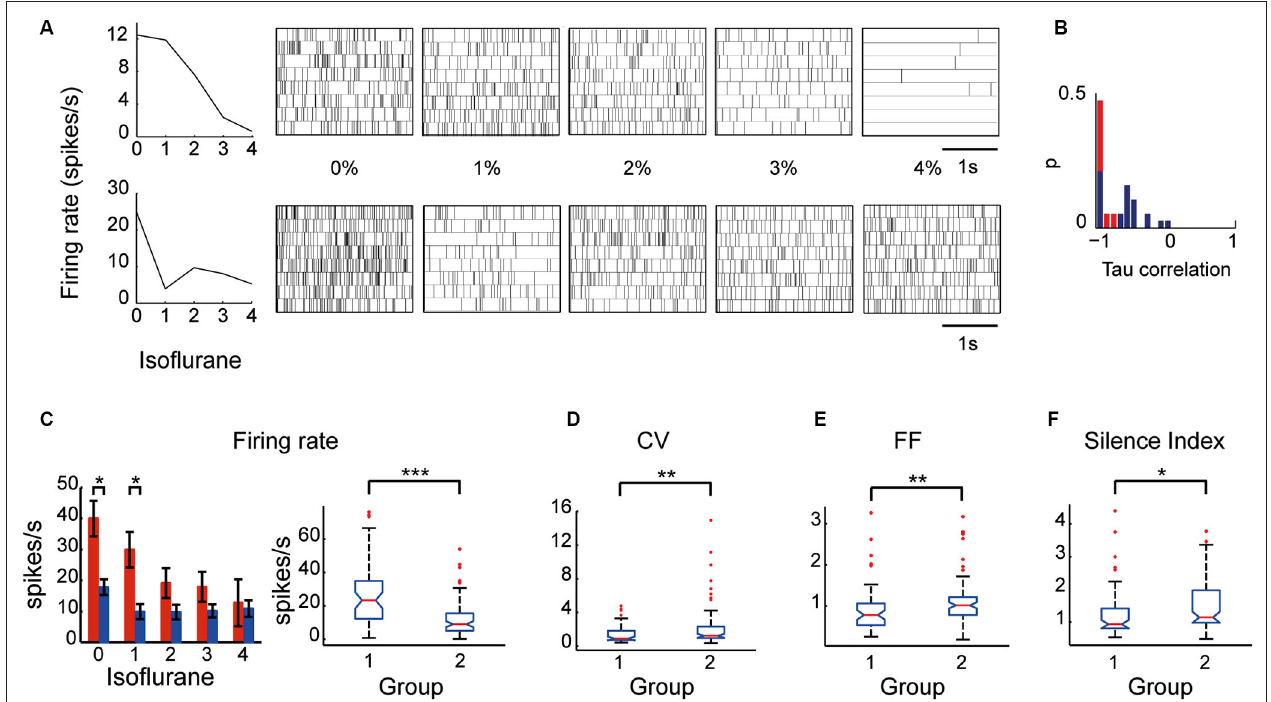
rate of the two groups (Group I is shown in red and Group II is shown in blue) during five states of anesthesia. (right) The boxplots depict the firing rate medians of the two groups under all conditions with the edges at the 25th and 75th percentiles. Vertical lines mark the 5th and the 95th percentiles. Red asterisks mark outliers. (D–F) Boxplots of CV (D) , FF (E) , and Silence Index (F) of the two groups under all conditions (* p < 0.05; ** p < 0.01; *** p <